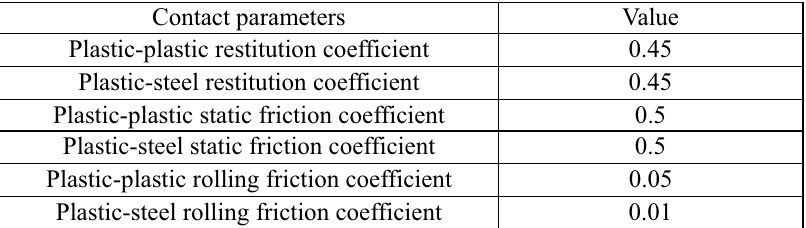
Table 3. Material contact